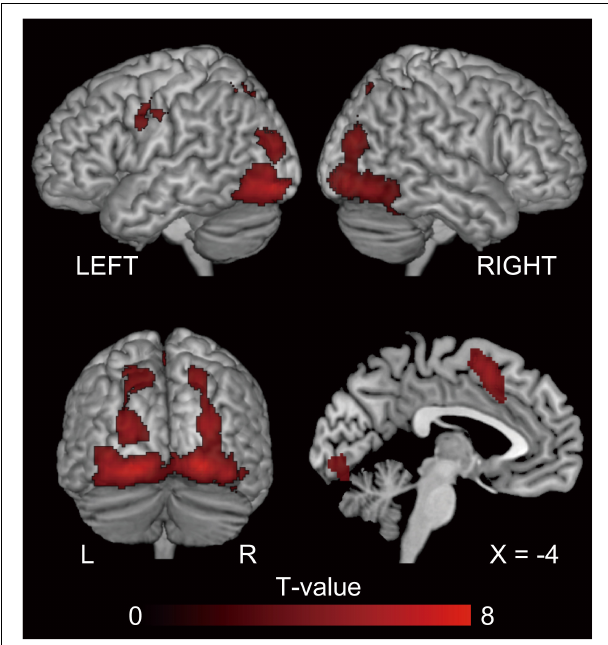
FIGURE 4 | The regions showing repetition suppression by cross-structural priming, excluding the effect of N priming (conjunction null analysis of [dP < nP] + [nN < dN] and [pD < nD] + [nN < pN]). P, D, and N represent Prepositional Object trials (PO), Double Object trials (DO), and No structure trials, respectively. In this cross-structural priming contrast, we aim to investigate the priming effect due to repetition of the function of semantic encoding. FWE-corrected p < 0.05 at the cluster level, with a height threshold of p < 0.001, uncorrected. These regions reflect a common processing between PO and DO. The activation is superimposed on the high-resolution T1 weighted MR